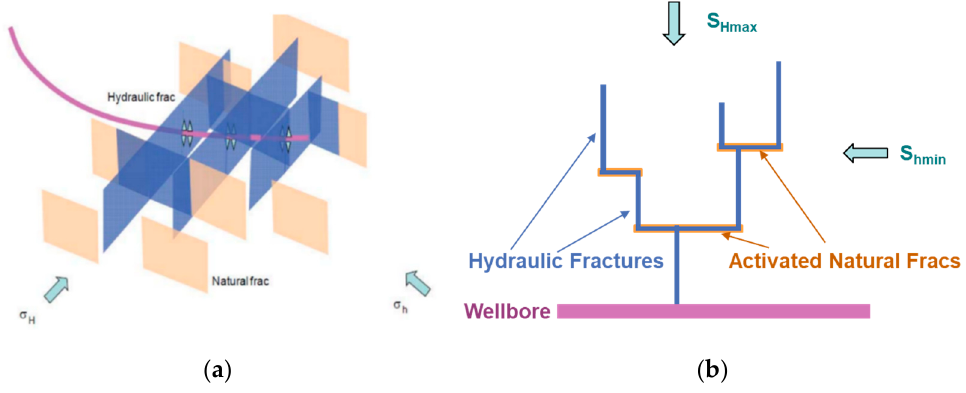
Figure 18. Complex fracture network created in the presence of natural fractures [30] ( a ). Hydraulic